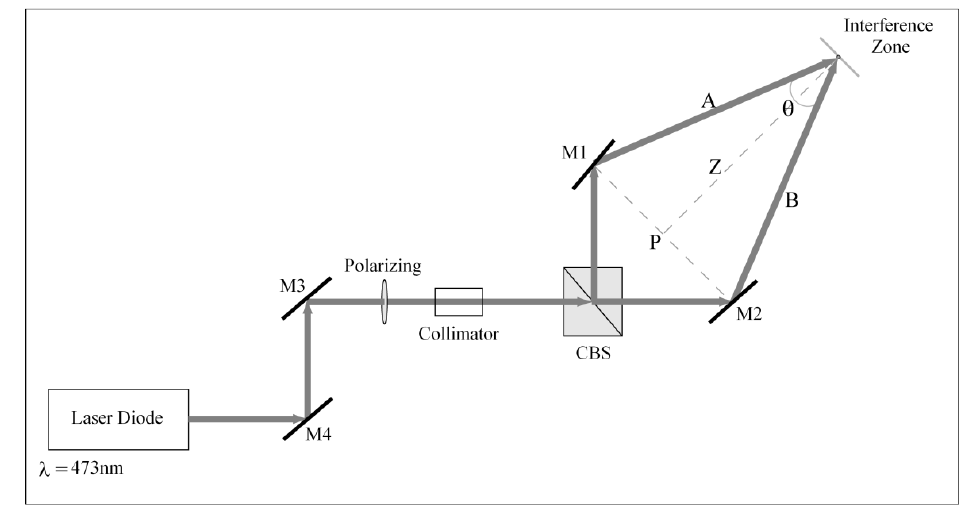
Figure 4. Experimental setup for the recording of holographic gratings in order to construct diffraction gratings with different frequencies and a recording beam at λ = 473 nm [30].